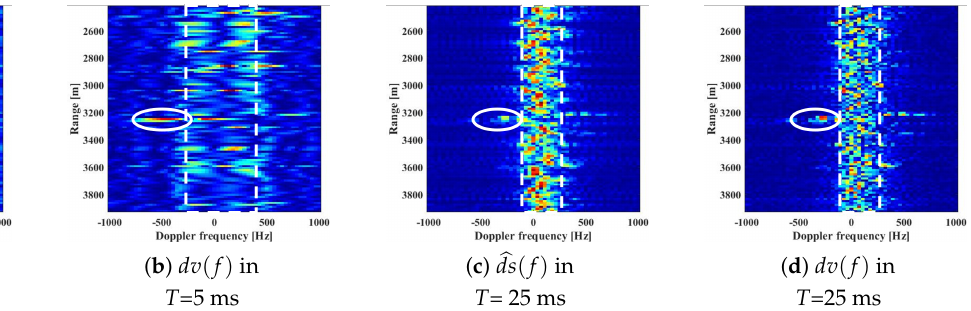
Figure 8. RD maps of